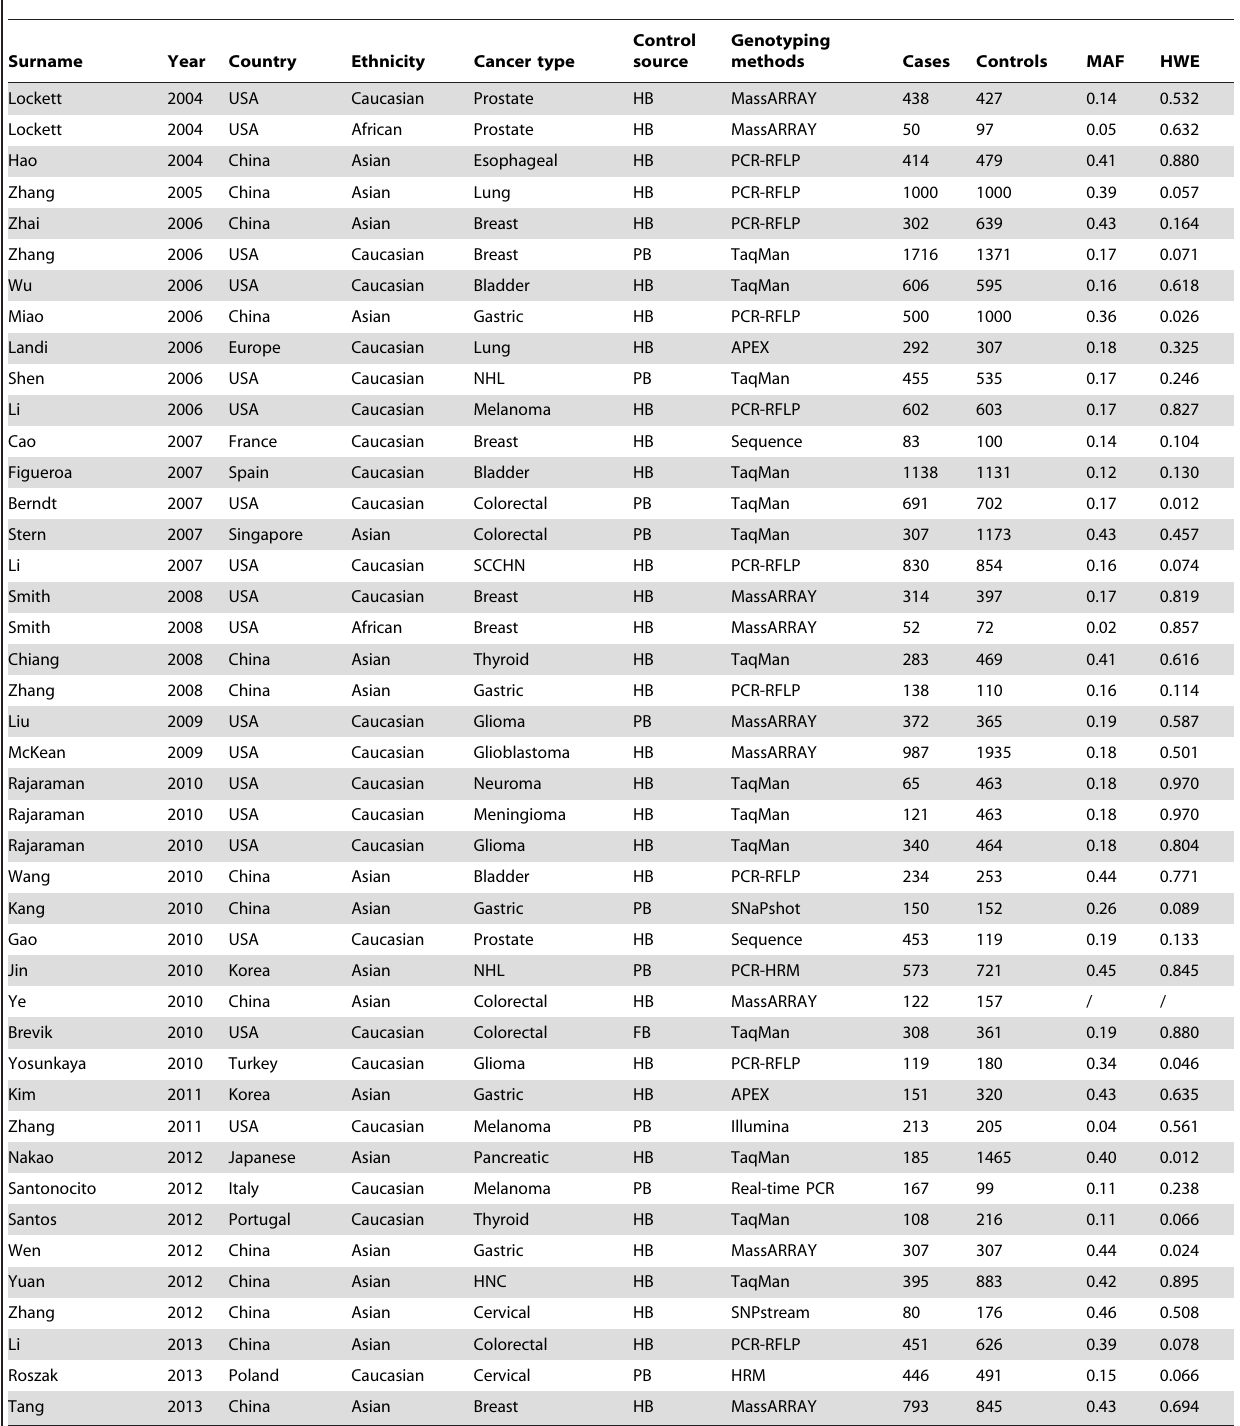
Table 1. Characteristics of the 43 studies included in the meta-analysis for an association between PARP1 Val762Ala polymorphism and risk of